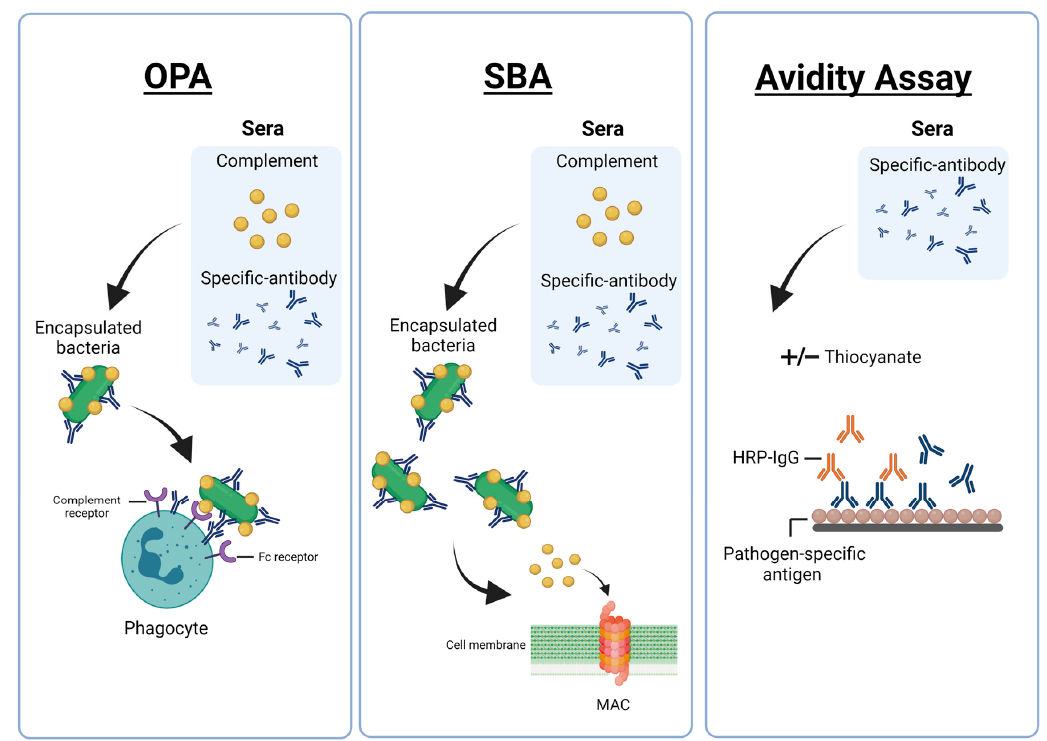
Figure 1. Theoretical concept of opsonophagocytic assays (OPA), serum bactericidal assay (SBA) and avidity assay. OPA: antigen-specific antibodies along with complement proteins opsonise encapsulated bacteria and facilitate uptake of the antibody-bacteria complex by phagocytes. SBA: antigen-specific antibodies recruit complement proteins that activate the complement cascade. This leads to the formation of the membrane attack complex (MAC) in the bacterial cell membrane, resulting in bacterial cell lysis. Avidity assay measures the strength of the antigen-antibody binding and is usually performed using a modified enzyme-linked immunosorbent assay (ELISA). Chaotropic agents such as thiocyanate are incubated with serum to elute antibodies that bind weakly to the